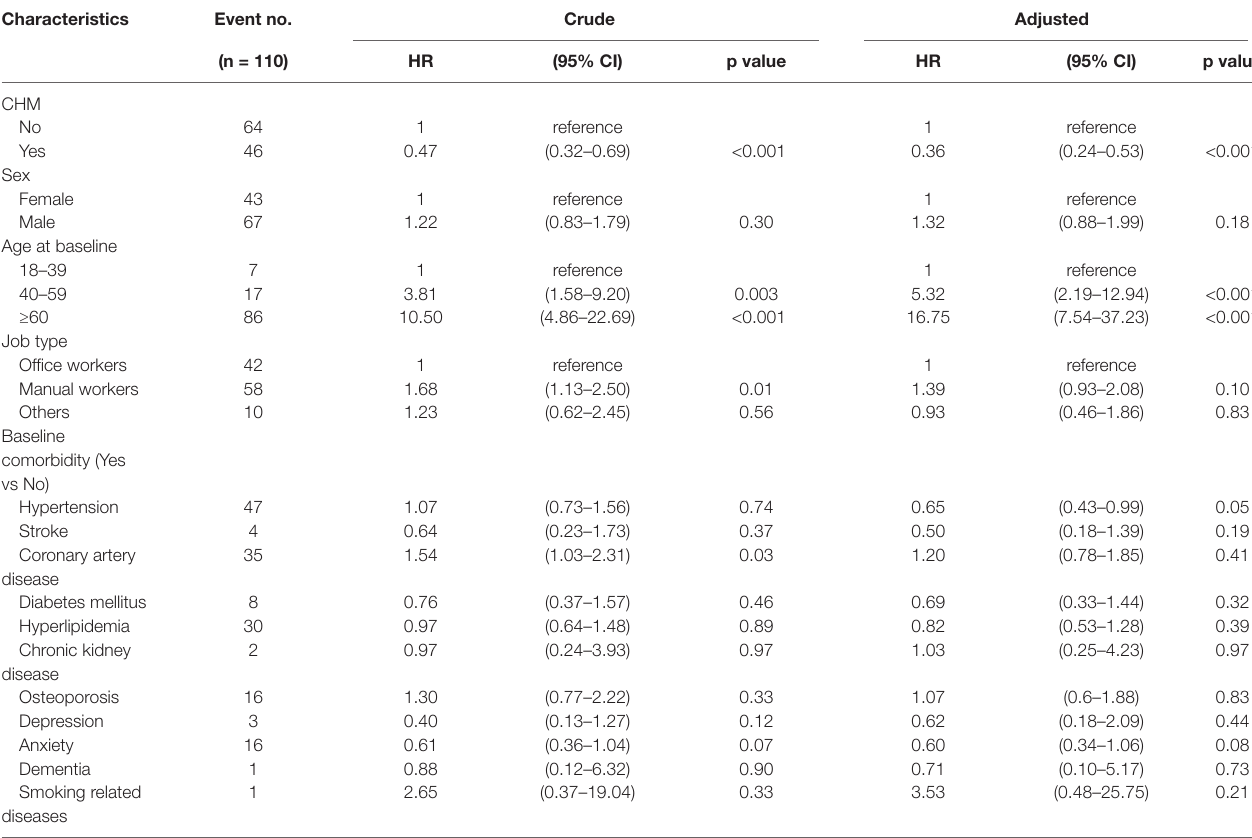
TABLE 2 | Cox model measured hazard ratio and 95% confidence intervals of lung cancer associated with and without CHM and covariates among COPD patients. Characteristics Event no.